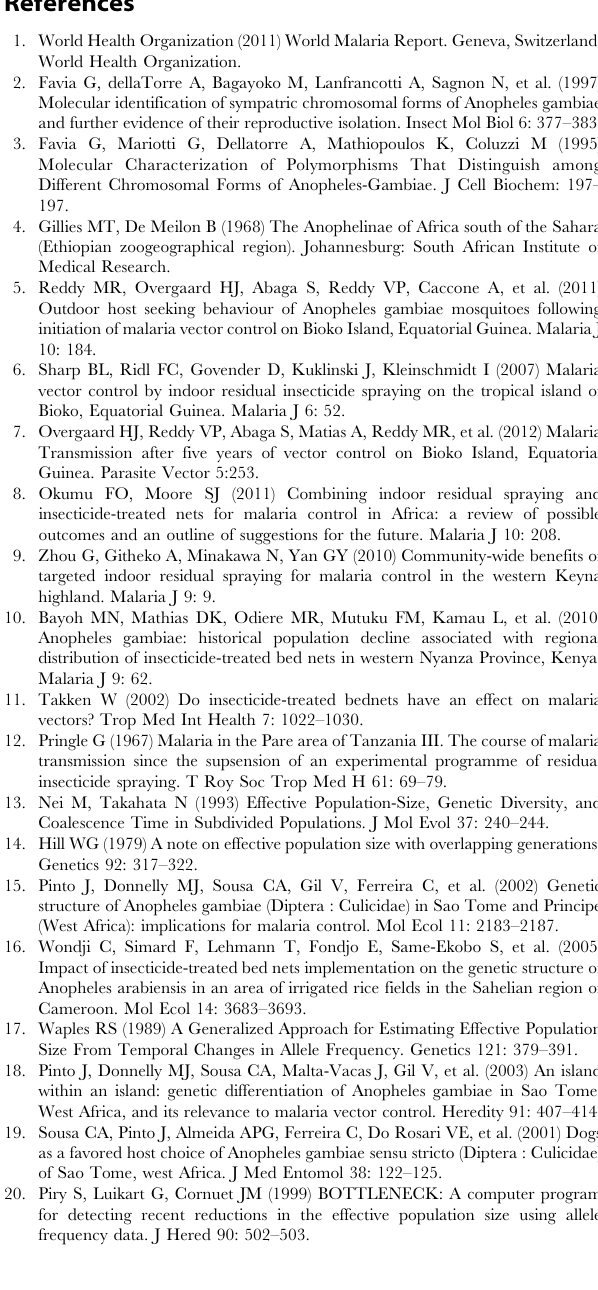
Table S2 A description of the most common demographic models tested using Approximate Bayesian Computation (ABC) on multiple time-point samples from Anopheline samples from each site. Generation between samples was customized for each species-site combination, assuming 24 generations/year. Addi- tional models or variants were also run based on each particular case or when one of the common models were not the substantially better than the competing